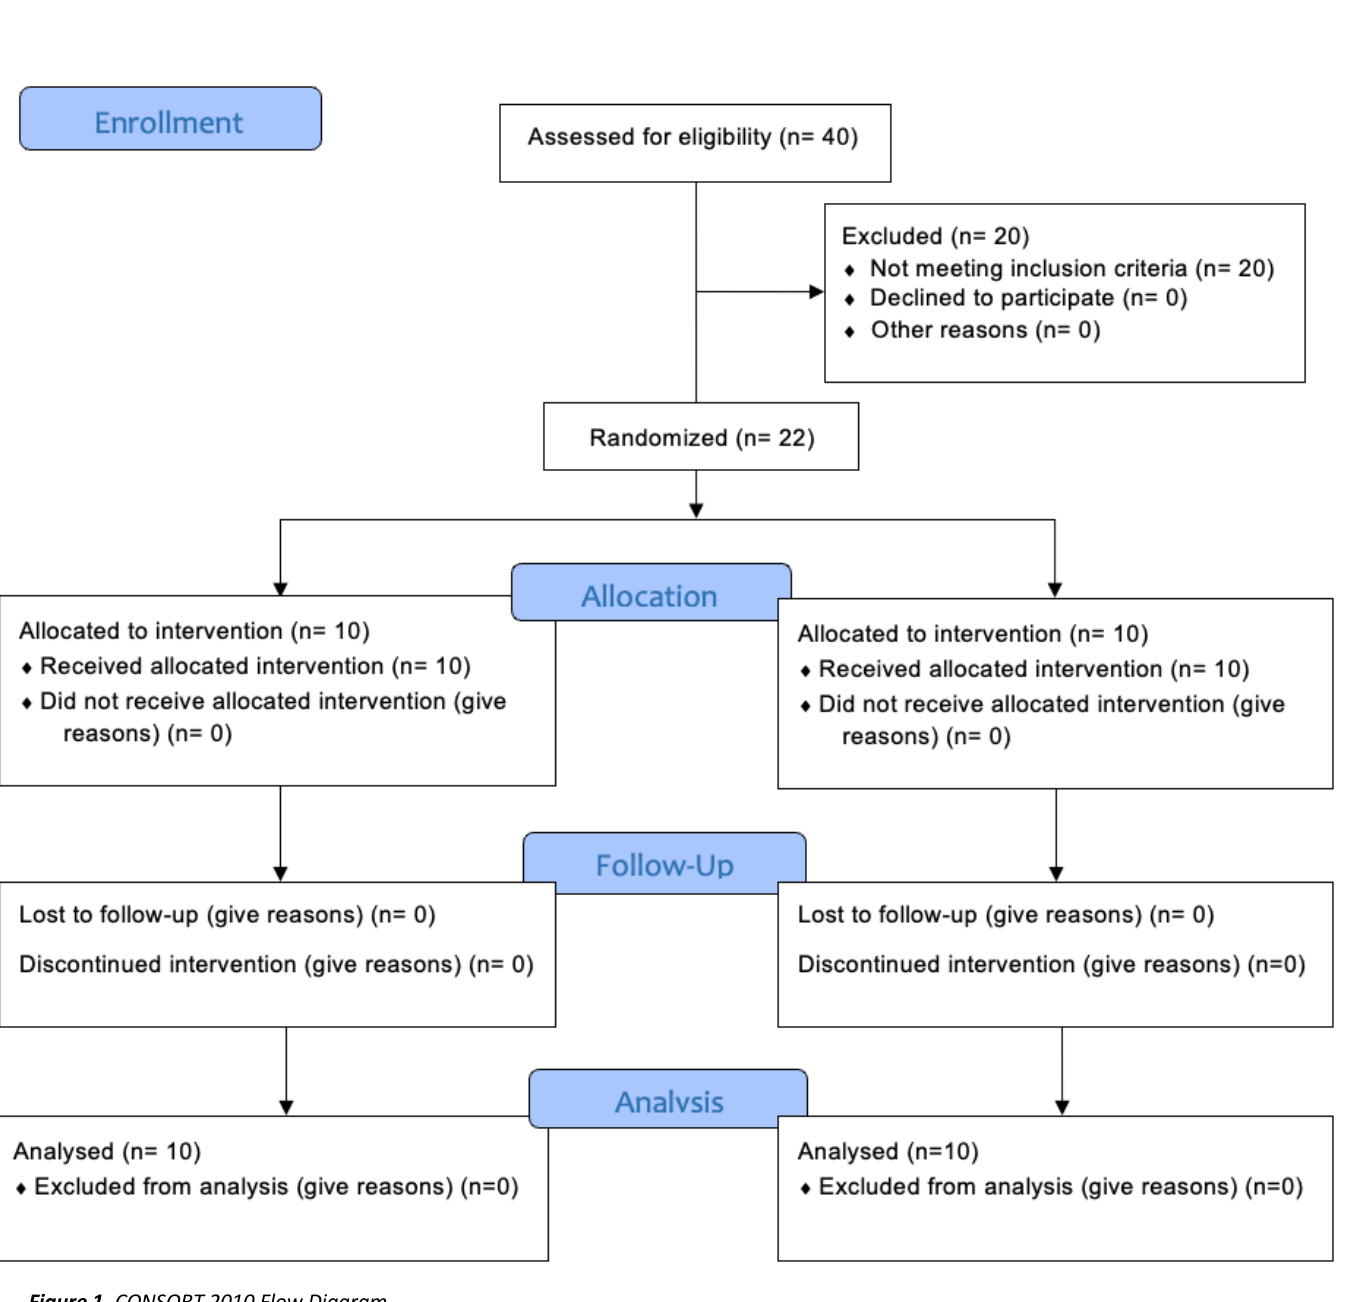
Figure 1. CONSORT 2010 Flow